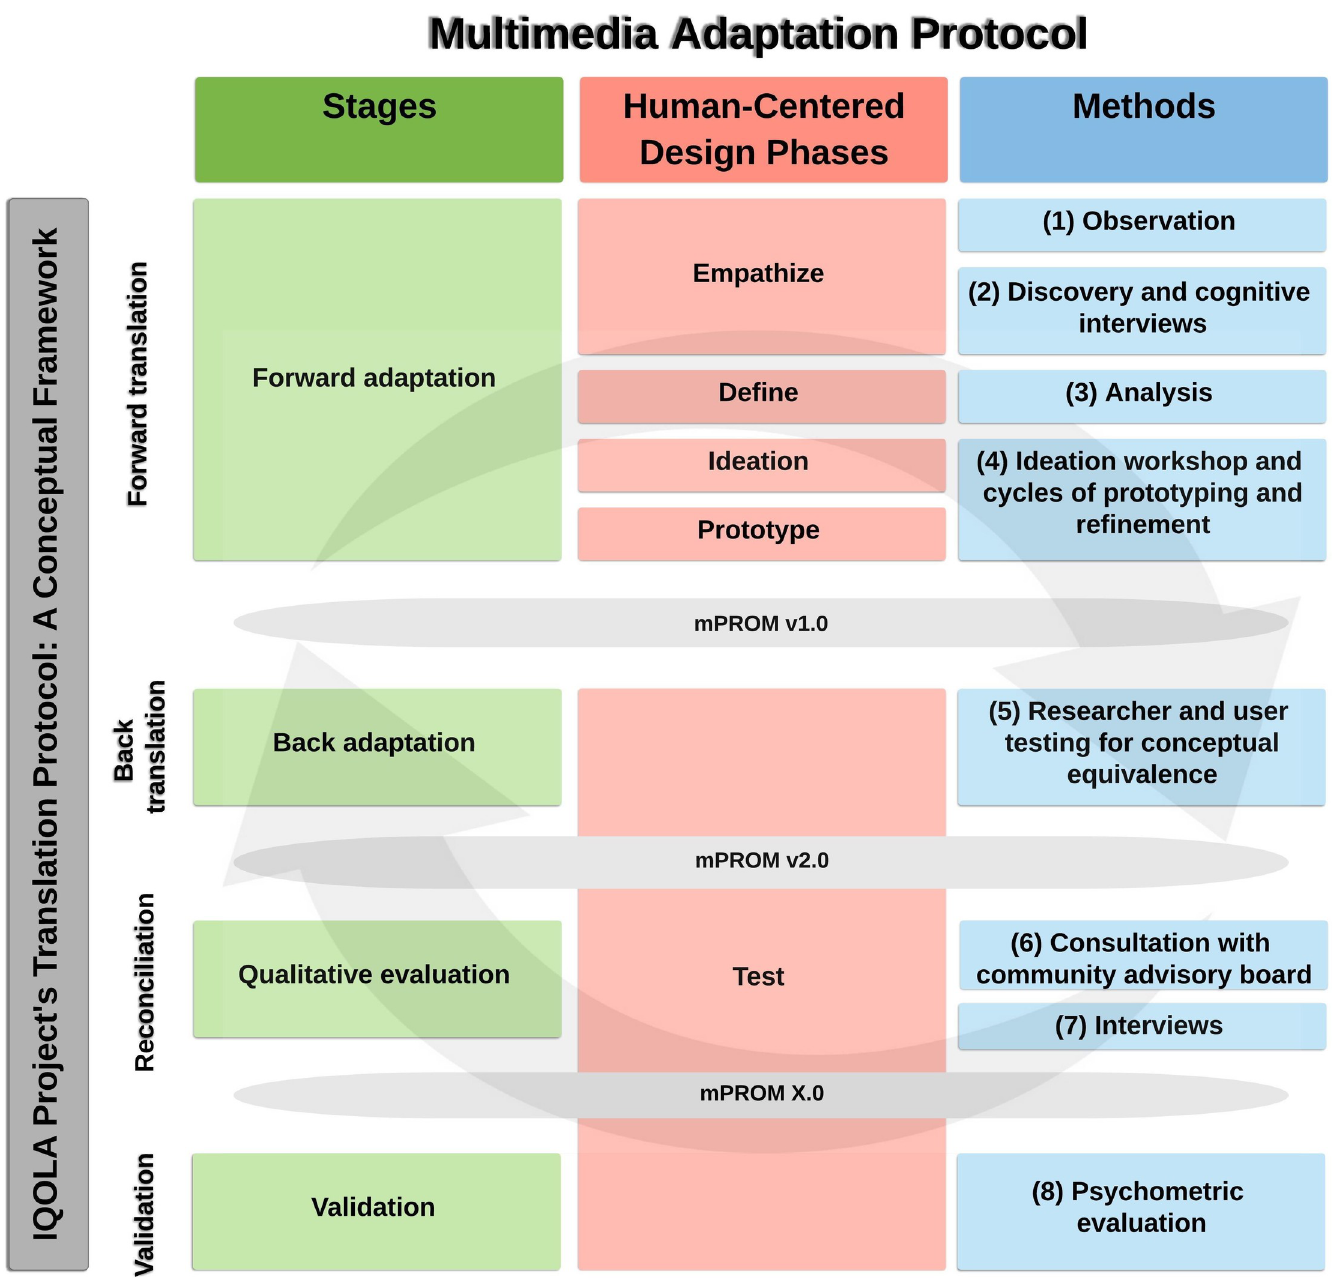
Fig 1. Multimedia Adaptation Protocol (MAP). The IQOLA Project Translation Protocol was used as a guiding conceptual framework to develop the MAP. The parallel components of the MAP include four stages (green), a human-centered design approach (red), and eight distinct methods (blue). (IQOLA = International Quality of Life Assessment; MAP = Multimedia Adaptation Protocol; HCD = human-centered design; mPROM = multimedia patient-reported outcomes measure; v1.0 = version 1.0; v2.0 = version 2.0; X.0 = final